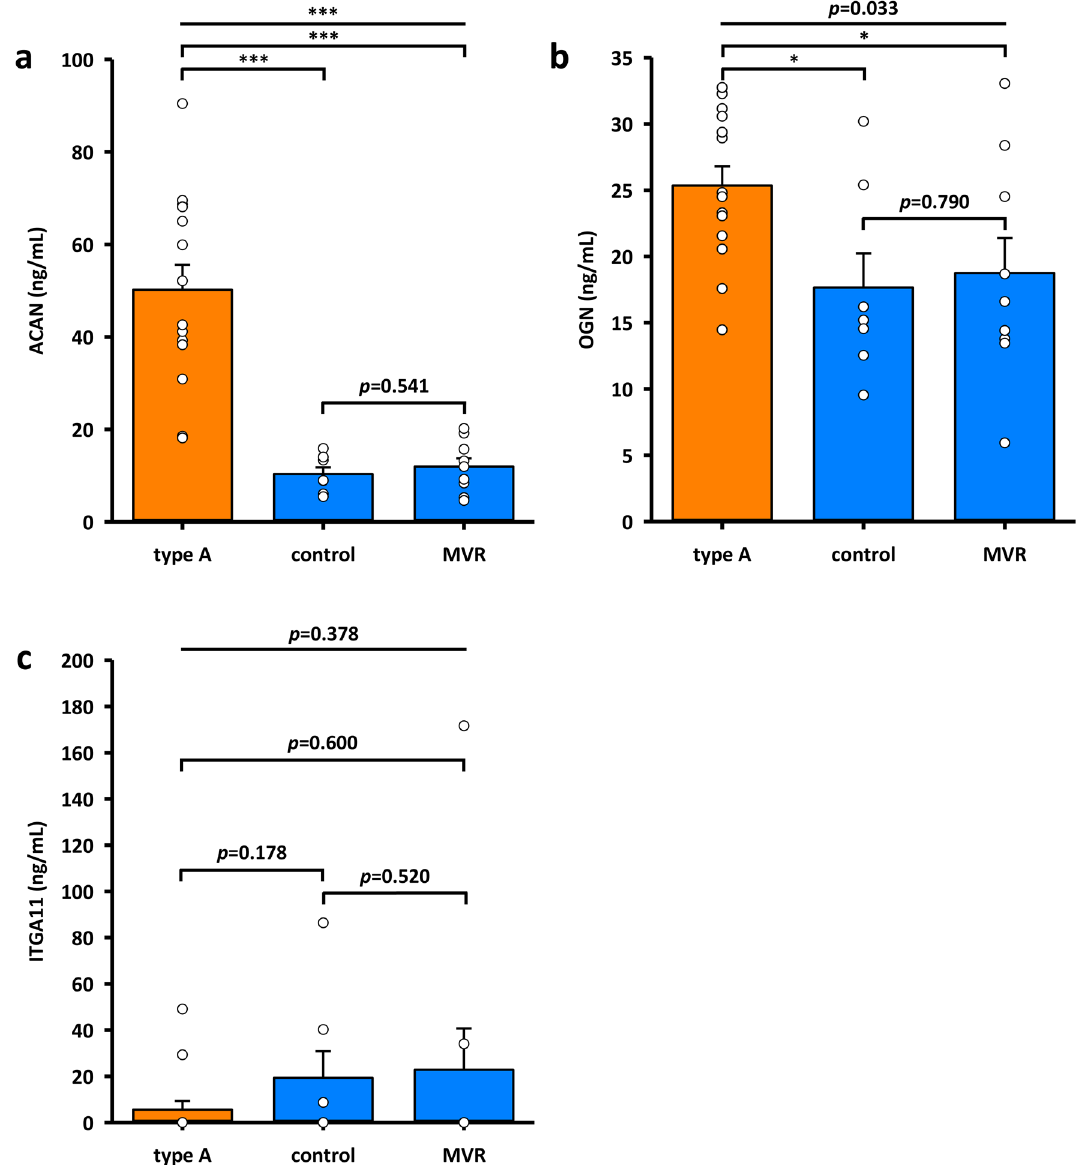
Figure 3. Protein concentration of candidate genes in plasma samples of type A dissection patients and control groups. Protein levels were quantified by commercial sandwich ELISA kits for ACAN [Aggrecan] (a) , OGN [Osteoglycin] (b) and ITGA11 [Integrin α 11] (c) . type A: acute type A aortic dissection (n = 14), control: healthy volunteers (n = 7), MVR mitral valve repair (n = 9). Values represent means ± SEM. *** p < 0.001. Significance of difference was tested with Wilcoxon-Mann–Whitney